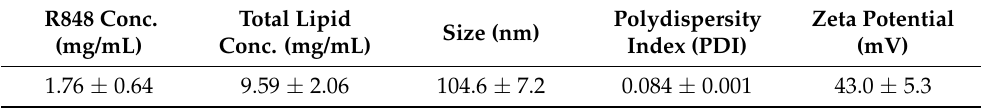
Table 1. Characterization of DSTAP-R848. Data = mean ± SD, n = 3. R848 Conc.